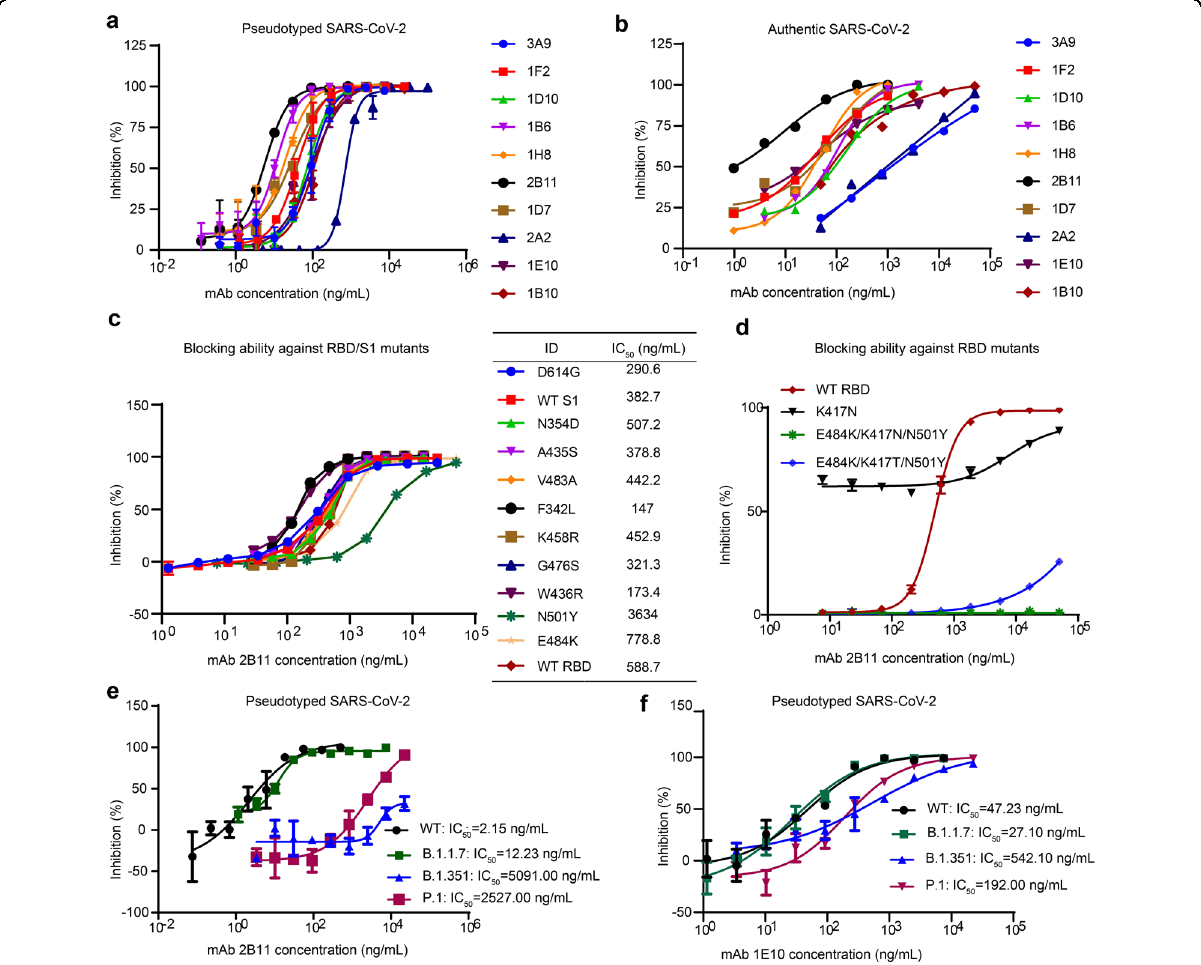
Fig. 3 Characteristics of the neutralization activity of the selected antibodies against WT SARS-CoV-2 and its emerging variants. The SARS- CoV-2-neutralizing activity of ten selected antibodies against pseudoviruses ( a ) and authentic viruses ( b ). Blocking activity of 2B11 against RBD/S1 single-point mutant proteins ( c ) and multipoint mutant proteins ( d ). Neutralization ability of the 2B11 ( e ) and 1E10 ( f ) mAbs against three newly dominant SARS-CoV-2 variants. WT refers to the original, non-mutated protein or